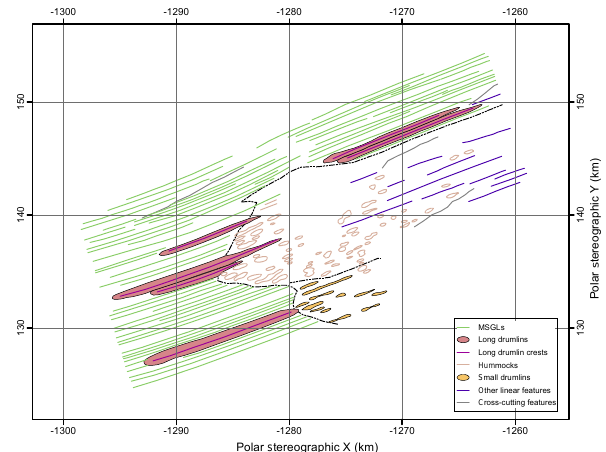
Figure 7. Geomorphological interpretation. The features of the bed of the ice stream can be classified into a number of different landforms and surface features, based on amplitude, length, outline shape and whether they are positive or negative landscape elements. See text for full descriptions of each class.